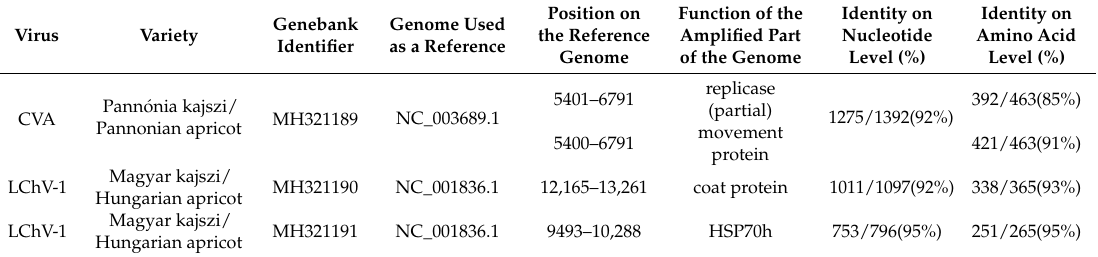
Table 2. Sequences of the amplified part of viruses uploaded into GenBank with their